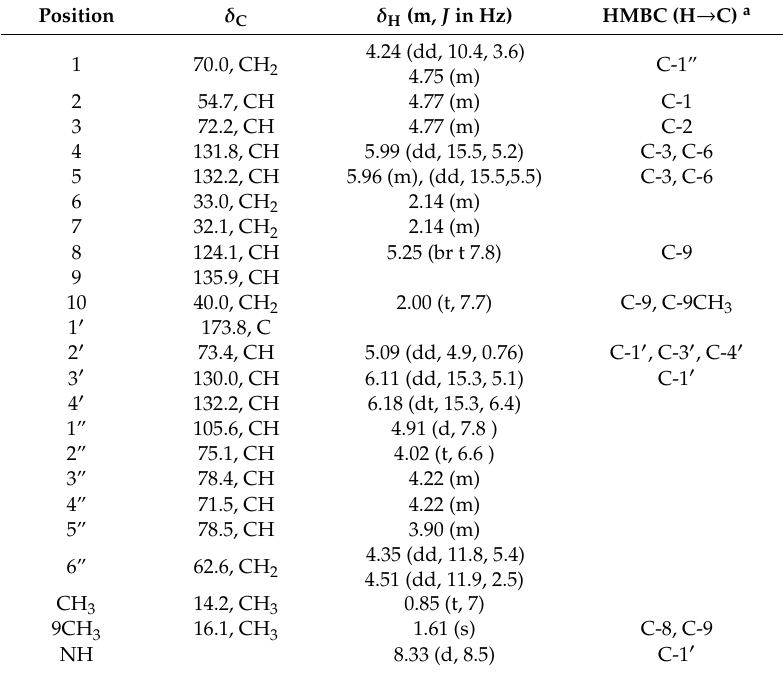
Table 1. NMR (Nuclear Magnetic Resonance) data of 1 (pyridine- d 5